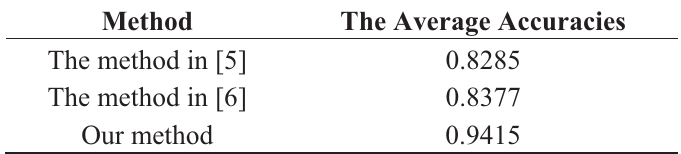
Table 1. The average accuracies of the different ROI extraction